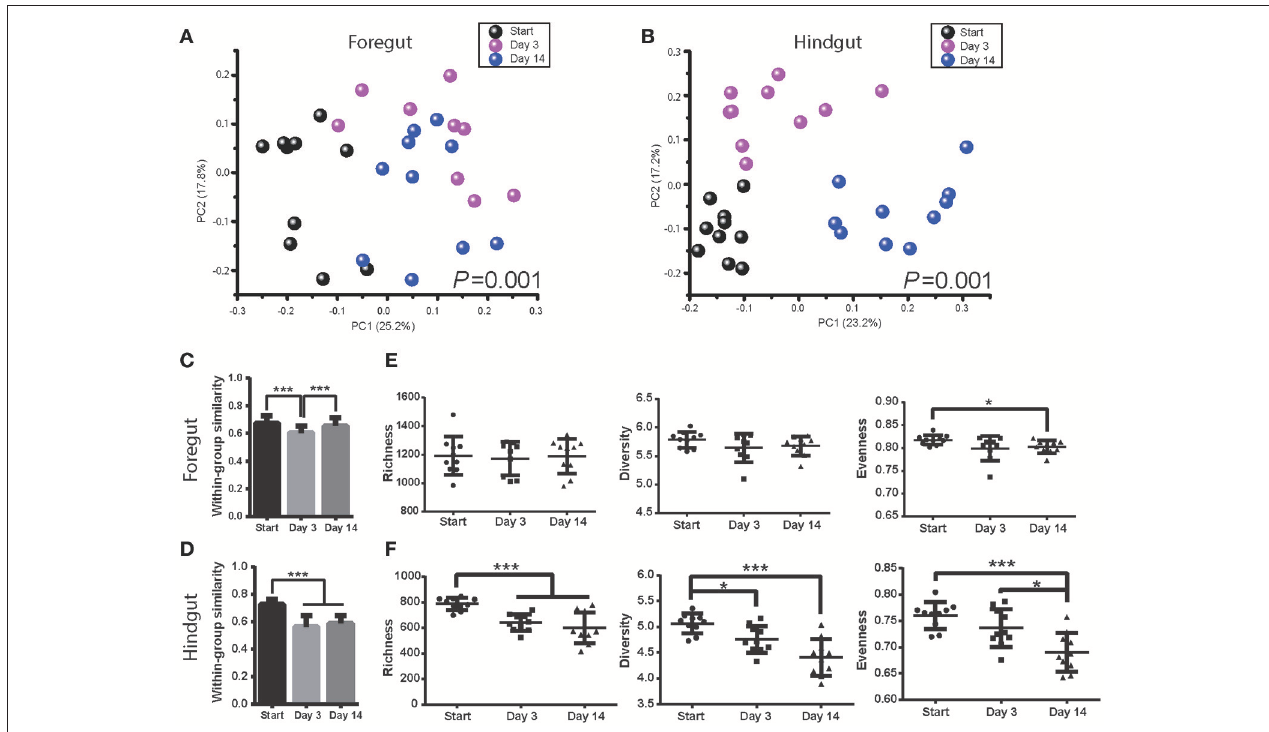
FIGURE 3 | Antibiotics altered foregut and hindgut microbiota. (A,B) Microbiota changes in foregut (A) and hindgut (B) after antibiotics exposure. Plot was drawn on the first two dimension of PCoA based on Bray-Curtis distance; statistical comparison of microbiota was performed with ANOSIM analysis. (C,D) Within-group similarities of microbiota change in foregut (C) and hindgut (D) after antibiotics exposure. Within-group similarity was calculated from Bray-Curtis metrics as 1-(Bray-Curtis distance). (E,F) Richness, diversity and evenness change of microbiota in foregut (E) and hindgut (F) after antibiotics exposure. Data are expressed as mean ± s.d. * P < 0.1, *** P <